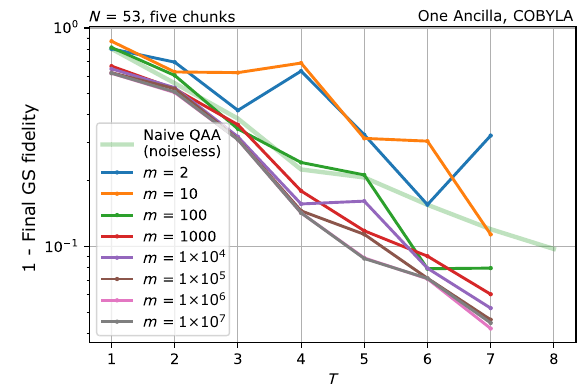
FIG. 17. The simulation of shot noise in the black-box algorithm for N = 53 and J = 1 using the one-ancilla method. The number of measurements taken for every ground-state over- lap estimation is given by m . Note that no extra noise is applied during the circuit. COBYLA is used as the classical optimizer. For m > 10 3 , the results begin to converge and the shot noise is sufficiently